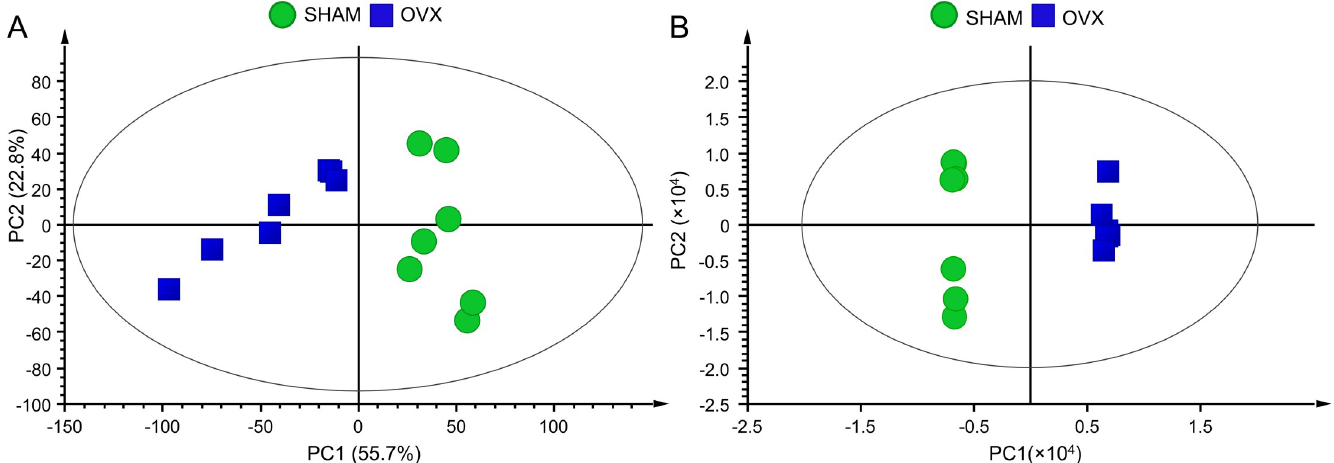
Fig 2. Multivariate data analysis of untargeted metabolomics profiles. (A) Principal component analysis. (B) Orthogonal projection to latent structure with discriminant analysis. Data were obtained from LC–MS-based untargeted metabolomics analysis of serum samples of sham-operated (SHAM) (green circles) and bilateral ovariectomized (OVX) (blue squares) rats at week 12 post-treatment ( n = 7 per group). PC, principal component.